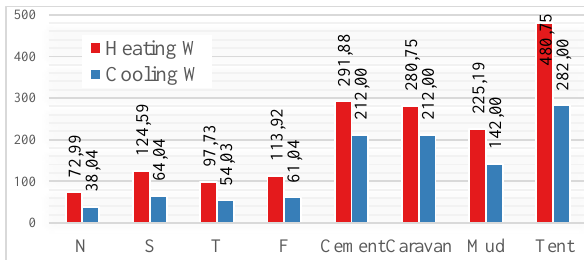
Figure 11. Heating and cooling load calculations for two months (W/ m 2 ).